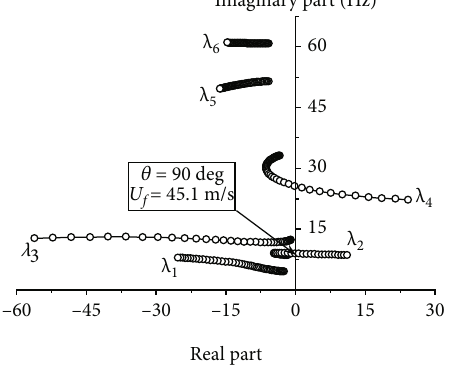
Figure 11: Evolution of open-loop eigenvalues with respect to the fl ow speed ( θ = 90 deg). Figure 9 is the comparison of the frequency response functions of the interpolated model and the exact model.